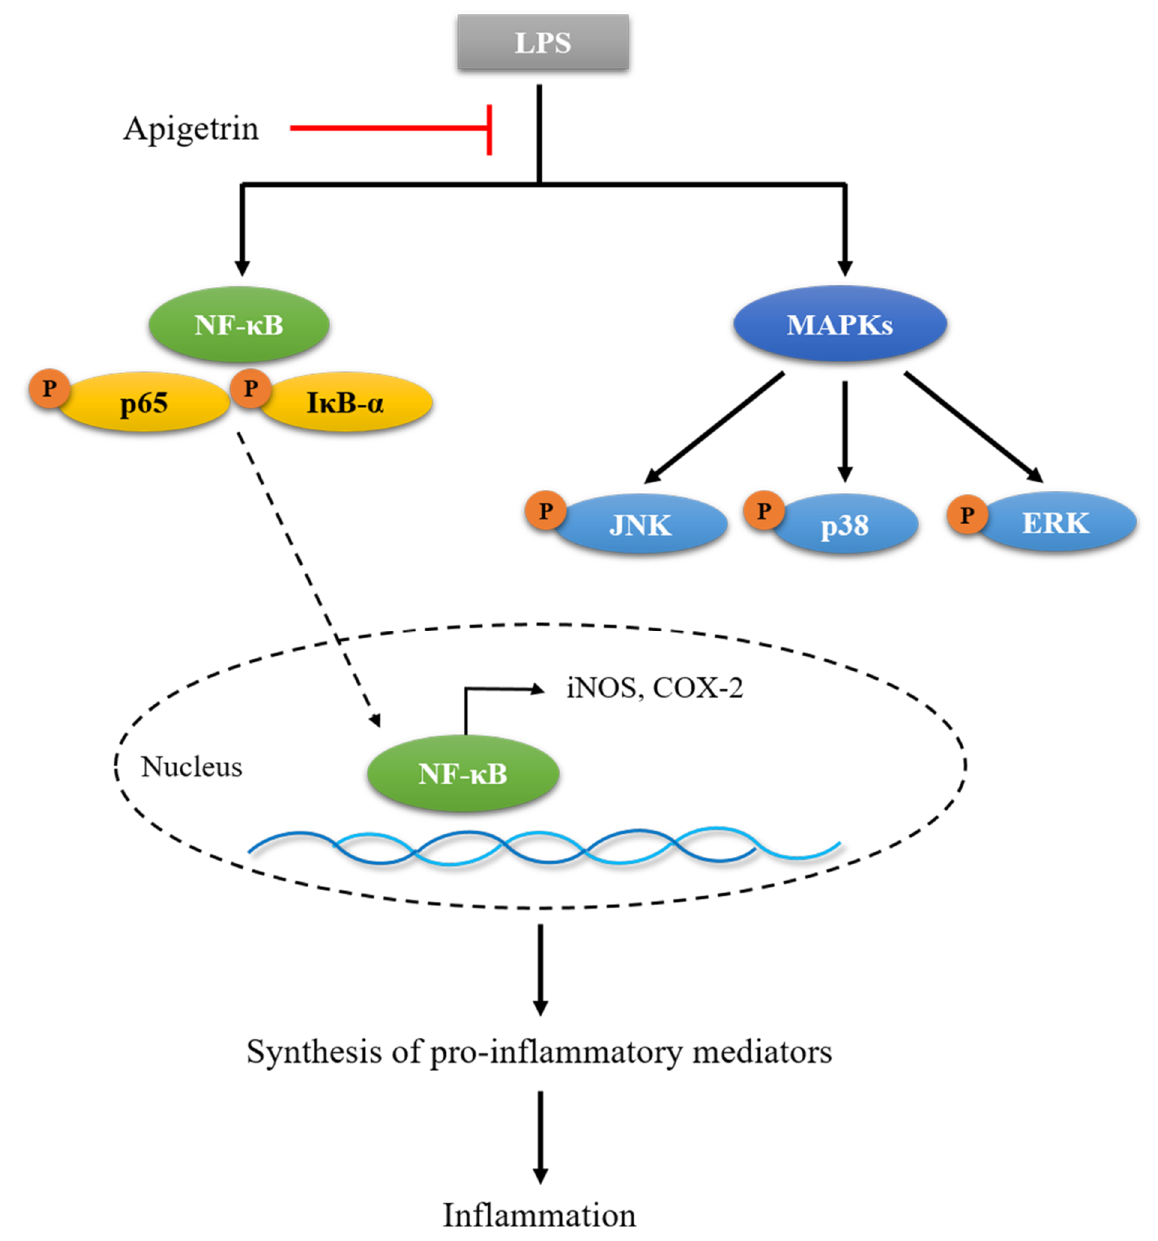
Figure 7. The proinflammatory pathway of apigetrin in L6 cells.